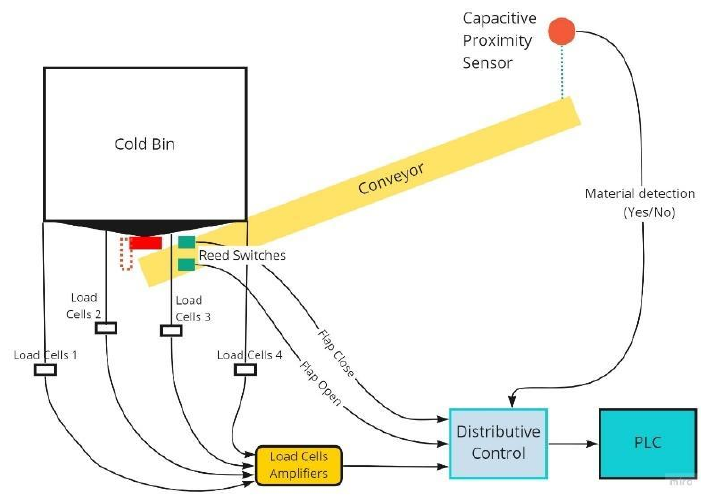
Figure 11. Aggregate Weighing and Conveying Process.